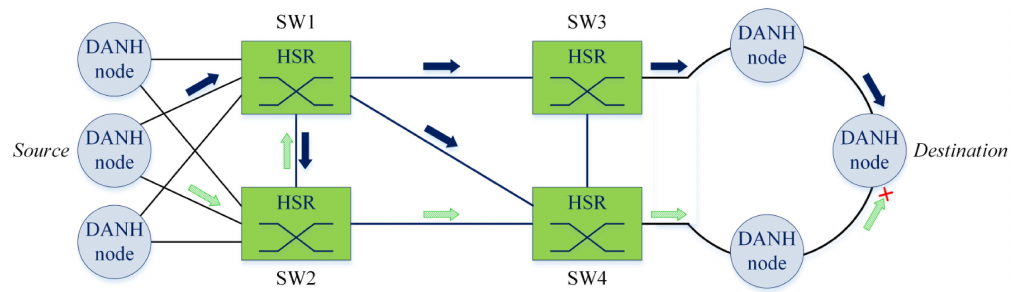
Figure 13. Forwarding a unicast frame in the failure-free case.